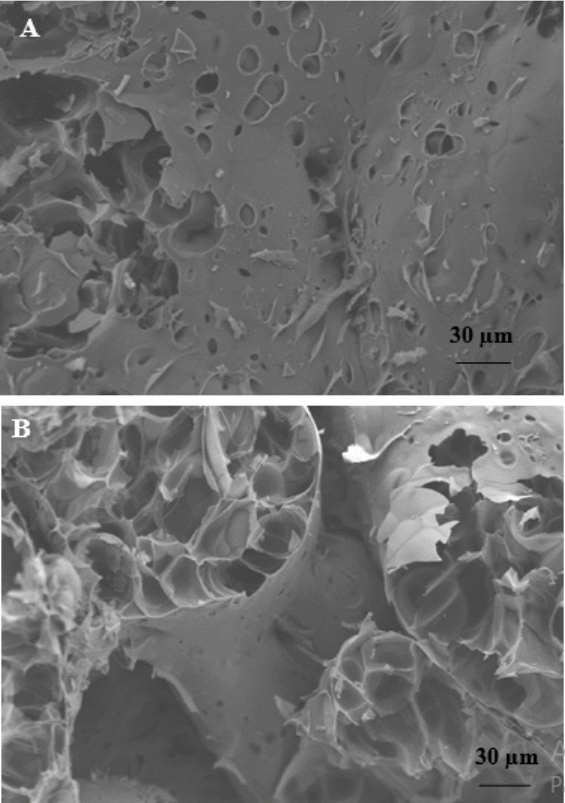
Figure 2. SEM image of ( A ) a perlite bead surface and ( B ) a perlite bead inner structure. Table 1. Mortars